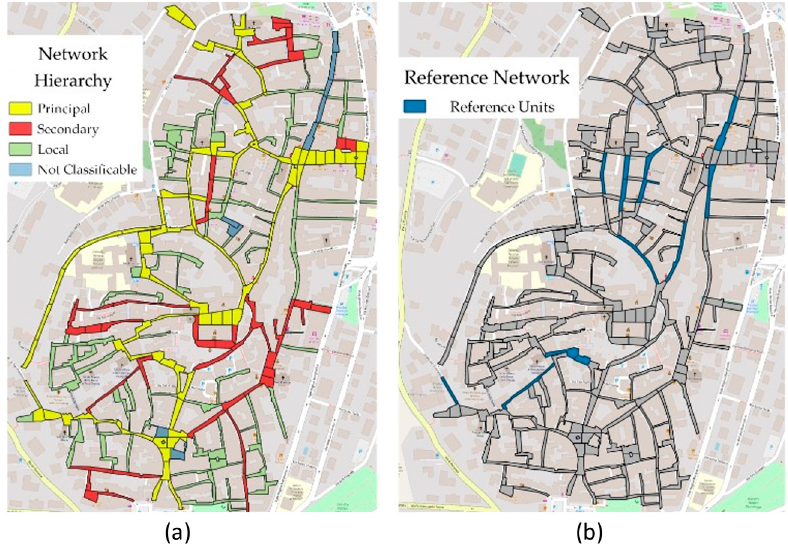
Figure 11. Stone pavement network in Velletri: ( a ) network hierarchy ( b ) reference network.